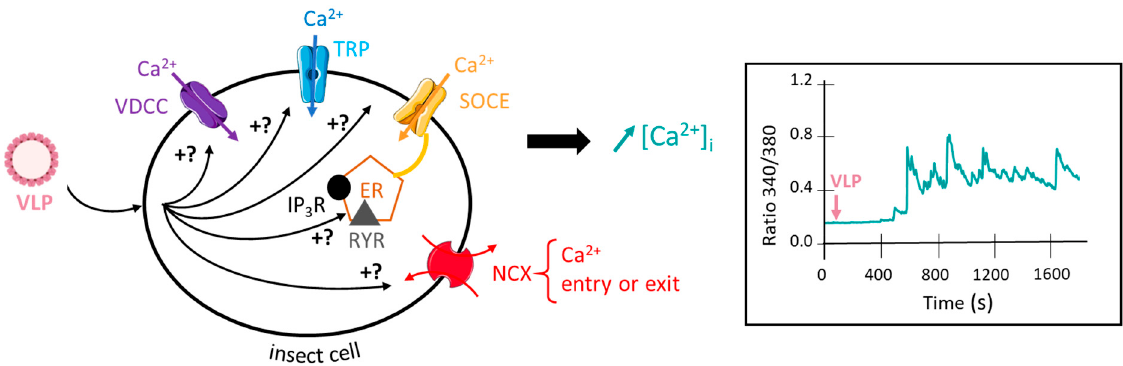
Figure 2. VLPs induce a multicomponent intracellular calcium rise. The scheme summarizes the hypothetic mechanisms by which VLPs increase intracellular calcium concentration. Inset: Representative multicomponent effect of VLPs on intracellular calcium concentration in Fura-2 loaded isolated insect neuron cell body using the calcium imaging ratiometric method (C. Deshayes, unpublished data). VDCC, voltage-dependent calcium channel; TRP, transient receptor potential channel; SOCE, store-operated calcium entry; NCX, sodium–calcium exchanger; RYR, ryanodine receptor; IP3R, inositol triphosphate receptor; ER, endoplasmic